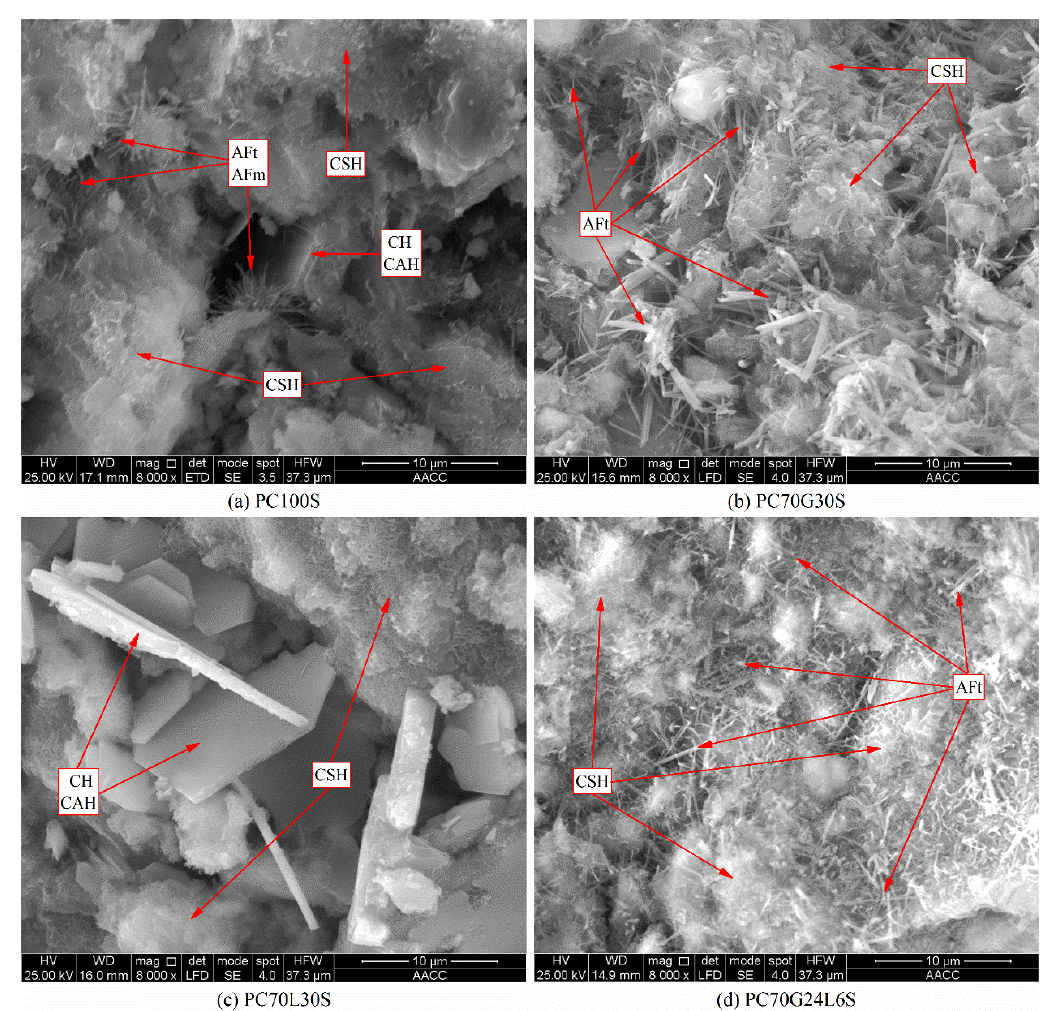
Figure 3. Scanning electron microscope (SEM) images of the stabilized soil